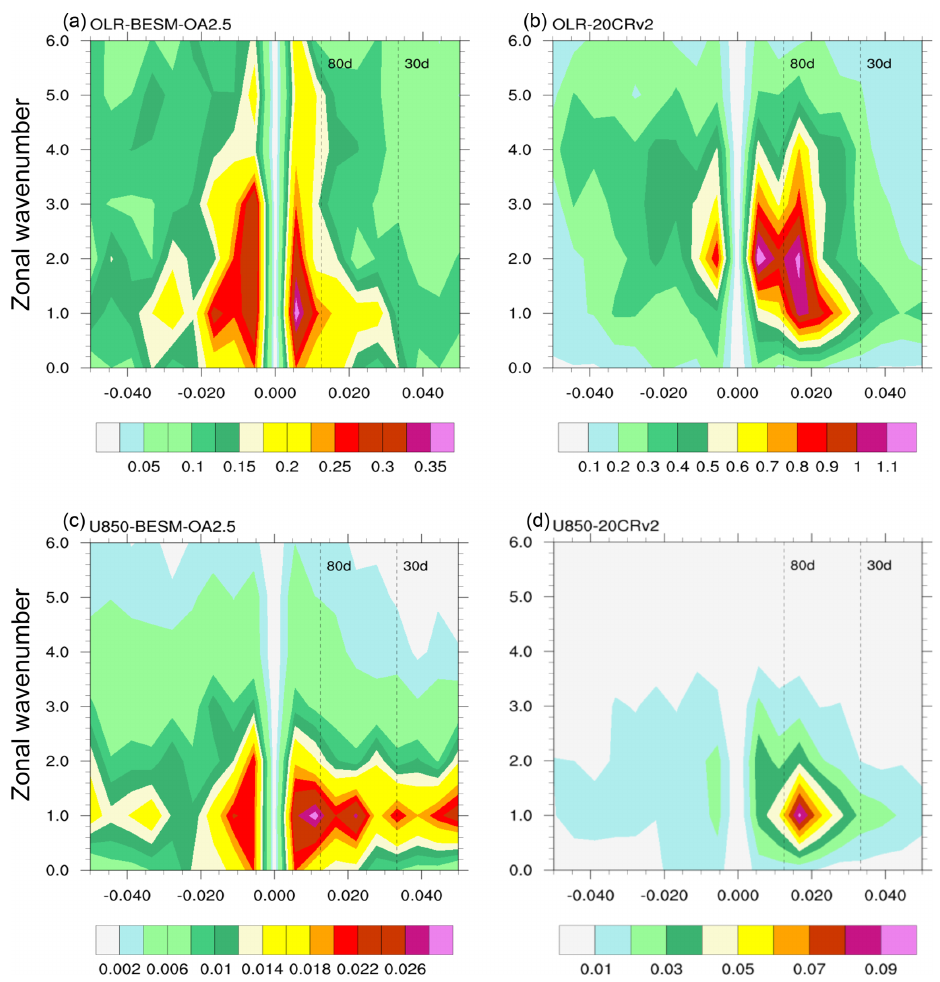
Figure 20. Wavenumber–frequency power spectra of the tropical (10 ◦ S–10 ◦ N) averaged daily outgoing longwave radiation (OLR) for (a) BESM-OA2.5 and (b) 20CRv2, and the averaged daily zonal wind component at 850hPa pressure level (U850) for (c) BESM-OA2.5 and (d) 20CRv2. The data used were the daily anomalies for the boreal winter (November–April) over the period 1971–2000. The daily anomalies were obtained by subtracting the climatological daily mean calculated over the period 1971–2000. Individual spectra were calculated for each boreal winter and then averaged over the time period used. Units for the zonal wind ( and OLR) are m − 2 s − 2 (and Wm − 2 s − 1 ) per frequency interval per wavenumber